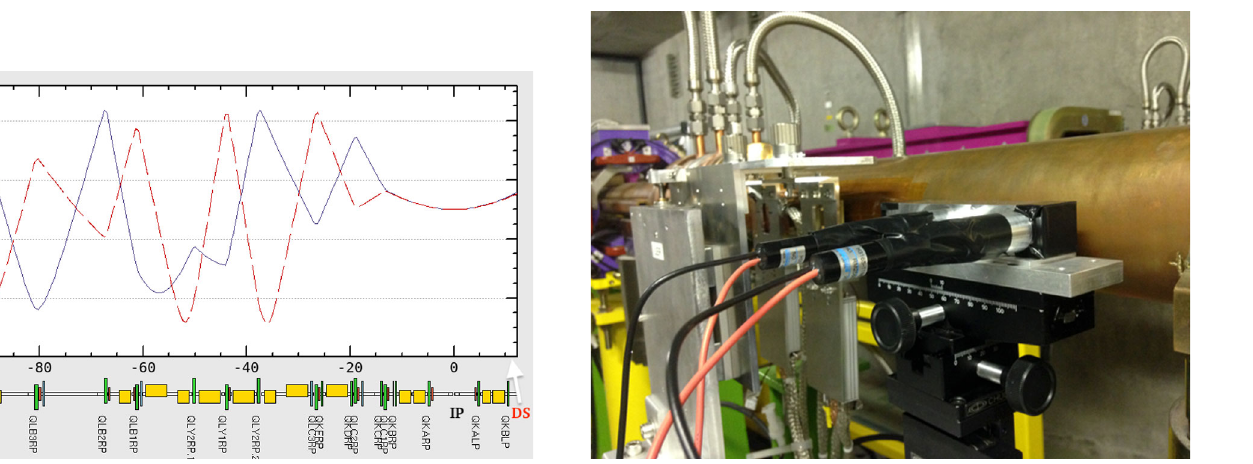
FIG. 13. The pillar in the LER located at 11.9 meters down- stream of the IP holding the two sCVDs and the Cherenkov and scintillator